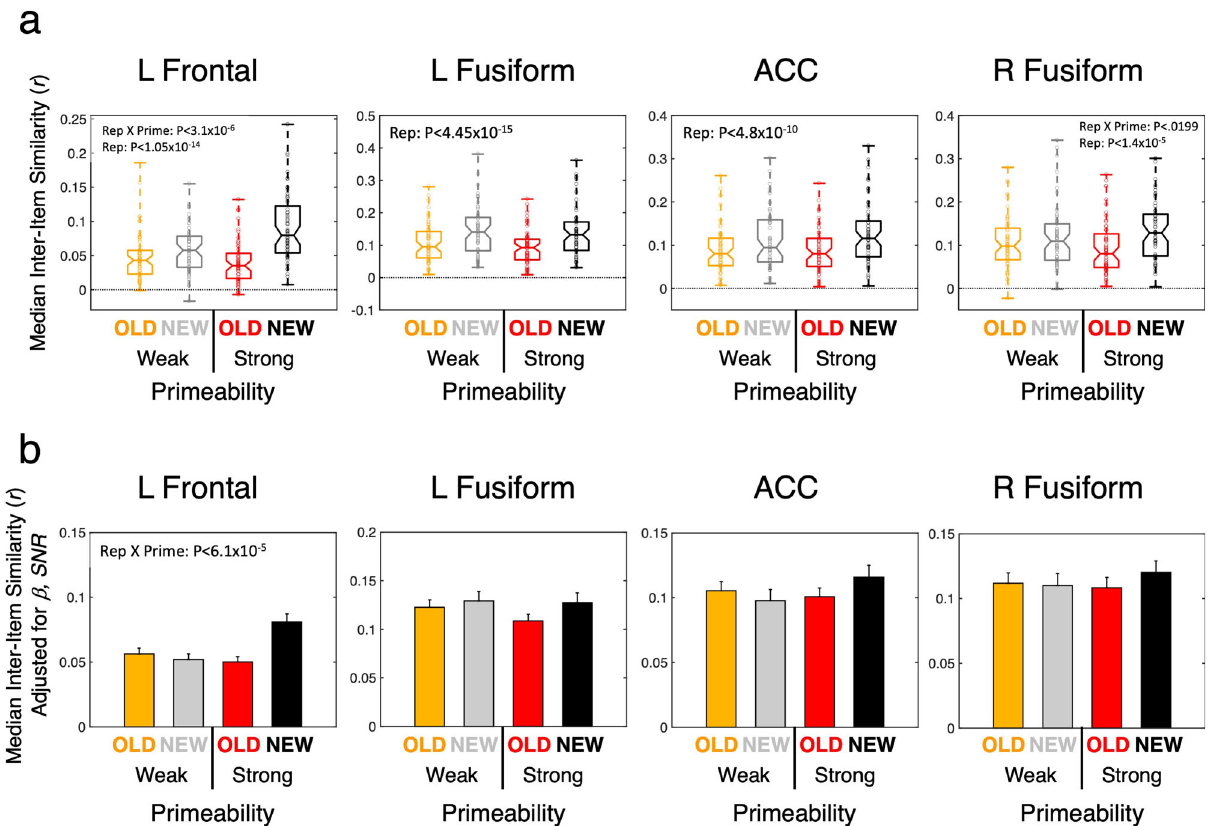
Fig. 8 MVPA tests of the Sharpening model. a Spatial correlations of peak responses on each individual trial were calculated across all trials per condition type using the full extent of the four Repetition Suppression (RS) clusters (see Supplementary Table 1), retaining the median inter-item correlation per participant. A signi fi cant Repetition × Primeability interaction was observed for the Left Frontal and ACC ROIs (corrected by FDR, q < 0.05). The middle horizontal line in each box plot represents the median (50th %ile), the horizontal lines just below and above the median represent the 25th and 75th %iles, the bottom and top horizontal lines represent the minimum and maximum values, and the boundaries of the horizontal notches inside the 25th and 75th% iles depict the 95% con fi dence limits of the median. Individual datapoints are plotted as open circles. b Strong covariation of the spatial correlations with average beta coef fi cients and estimated signal-to-noise ratio eliminated most of the differences between conditions after adjustment for these variables, leaving only a signi fi cant Repetition × Primeability interaction in the Left Frontal ROI. Bar plots are used along with standard error of the mean (SE) estimates, since these adjusted means and model-residual error are not de fi ned on the individual participants and only on the full LME model. Statistics are based on N = 60 independent participants, organized into a factorial design with Task (Overt, Covert Naming) as a between-participant variable (Primeability and Repetition are within-participant variables). For related content in SI, see Supplementary Fig.